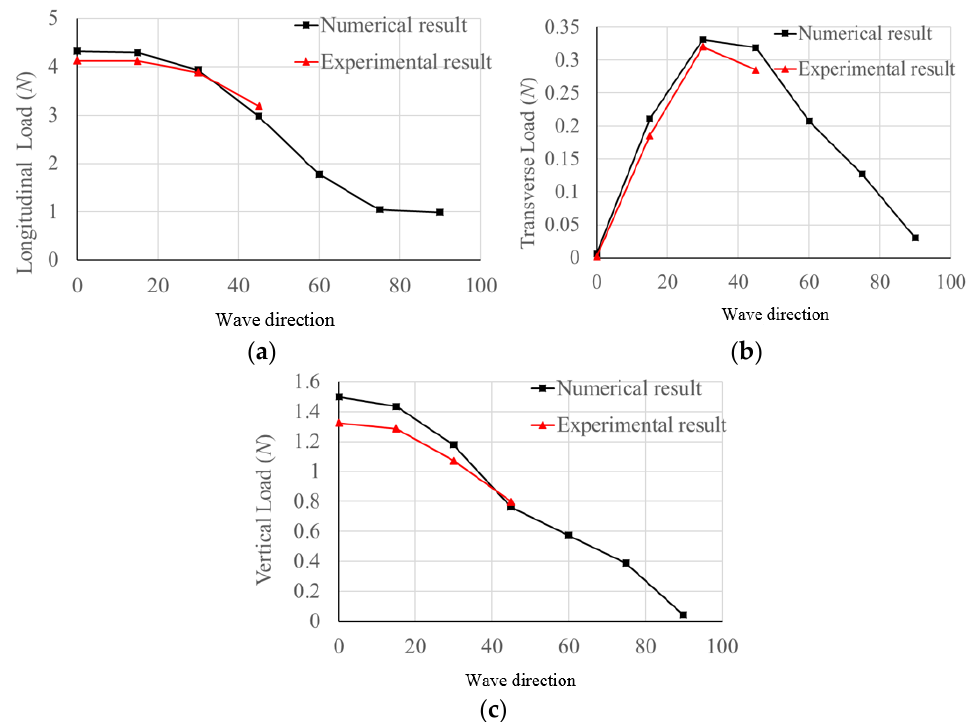
Figure 14. Loads on the hinged connector: ( a ) longitudinal load; ( b ) transverse load; ( c ) vertical load.